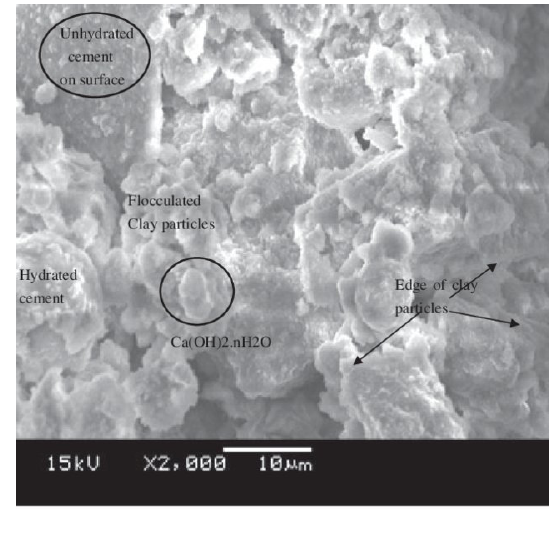
Figure 4: SEM image of cement-treated clay immediately after compaction (Zhao et al.,